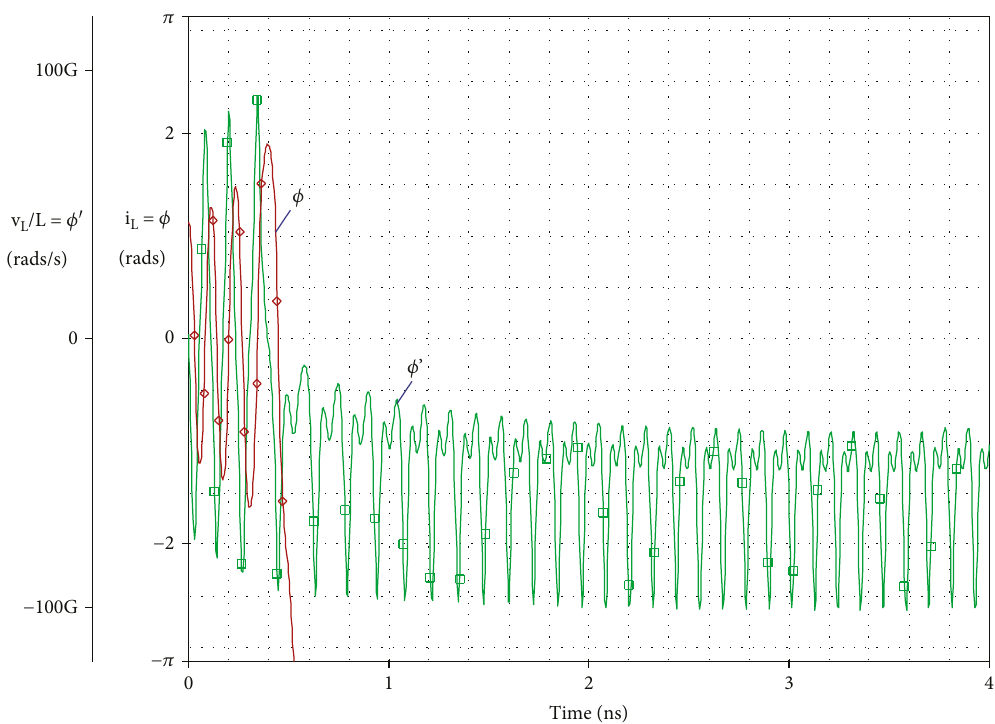
Figure 8: SPICE simulation of circuit from Figure 4(a) under conditions (58). According to the classical and Chua ’ s duality, the inductor current describes the time evolution of the azimuthal angle of rotation of spin-torque oscillator from [30], and the inductor voltage is proportional to the rotation speed. The transient analysis predicts the steady-state oscillations with the repeating frequency of